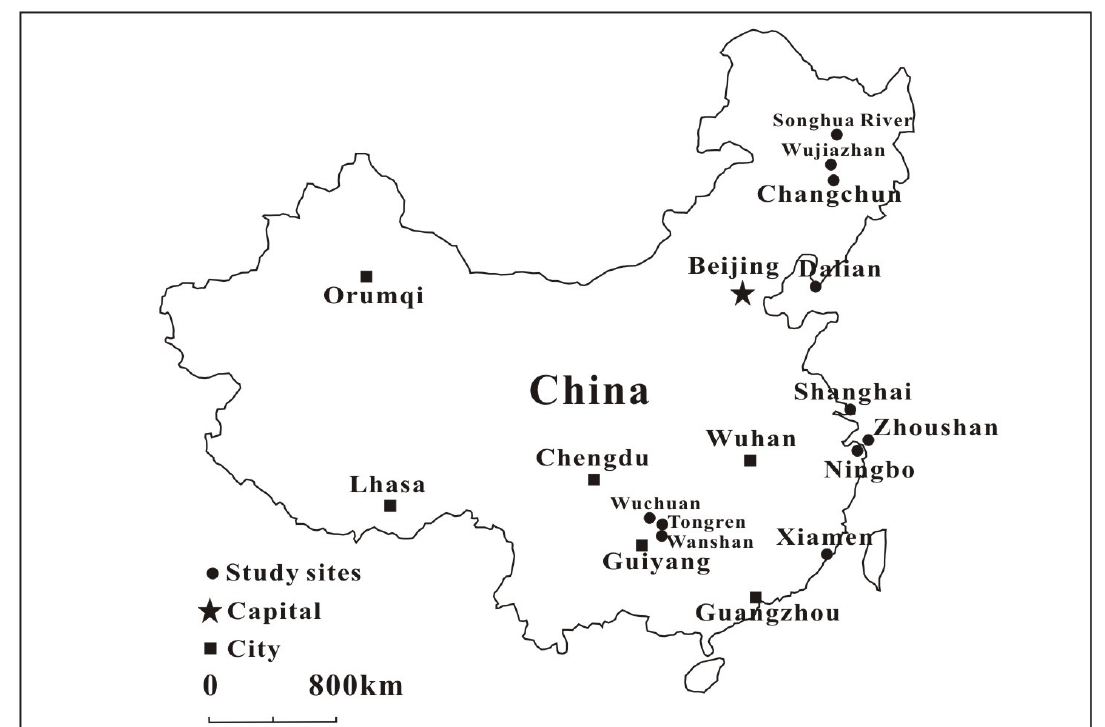
Figure 2. Location of study sites of hair Hg investigation in